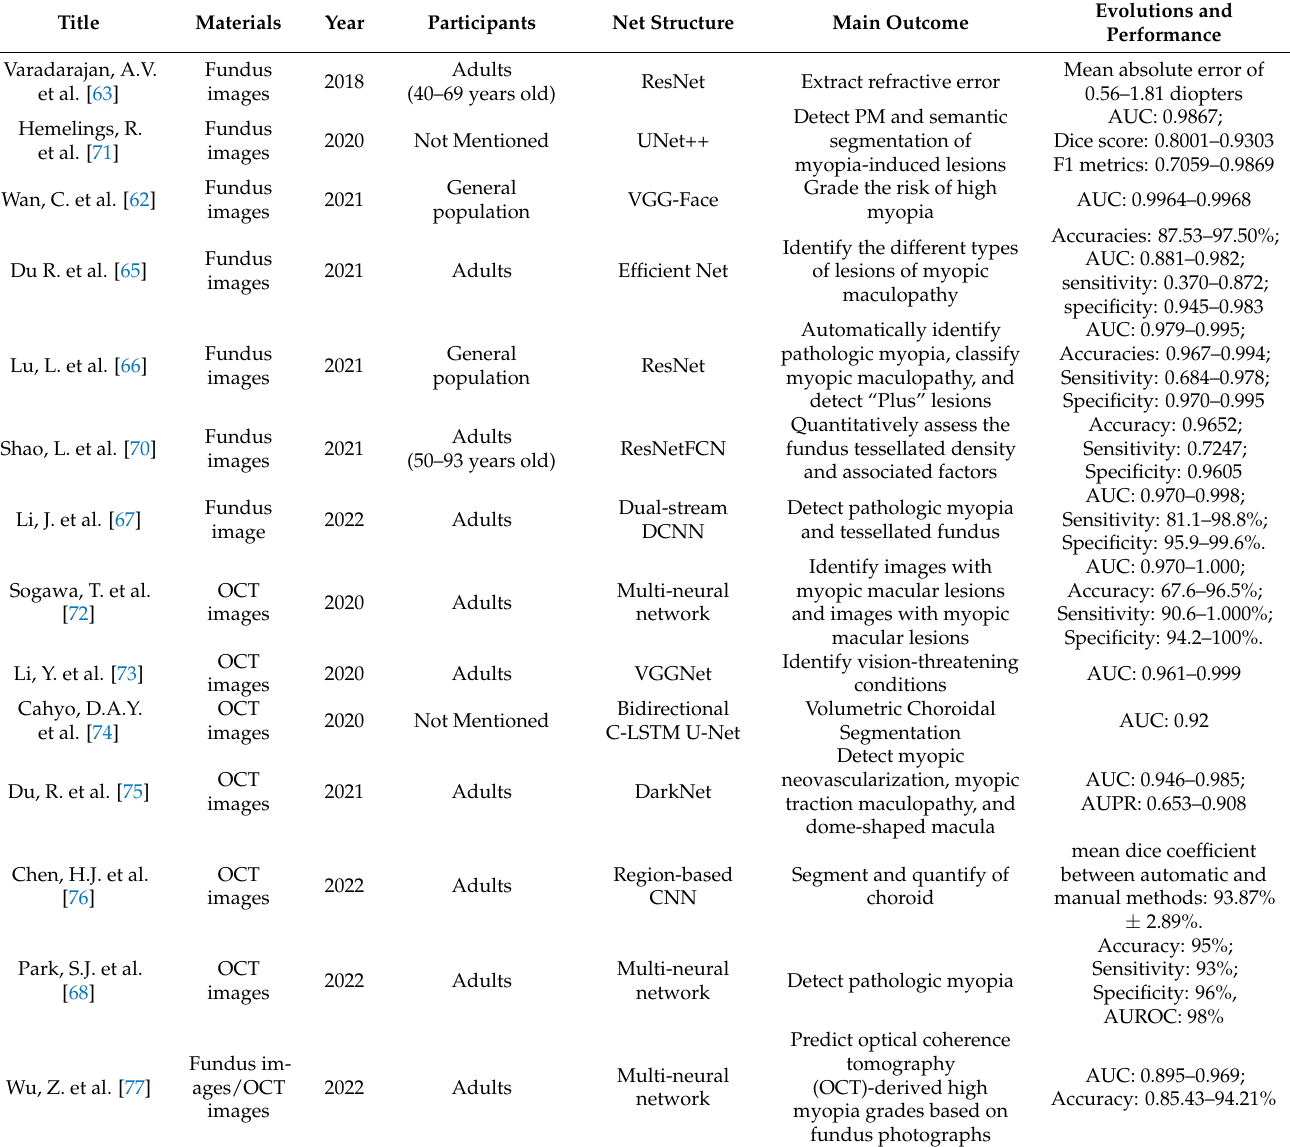
Table 2. Image-driven artificial intelligence (AI) models in high myopia and pathologic